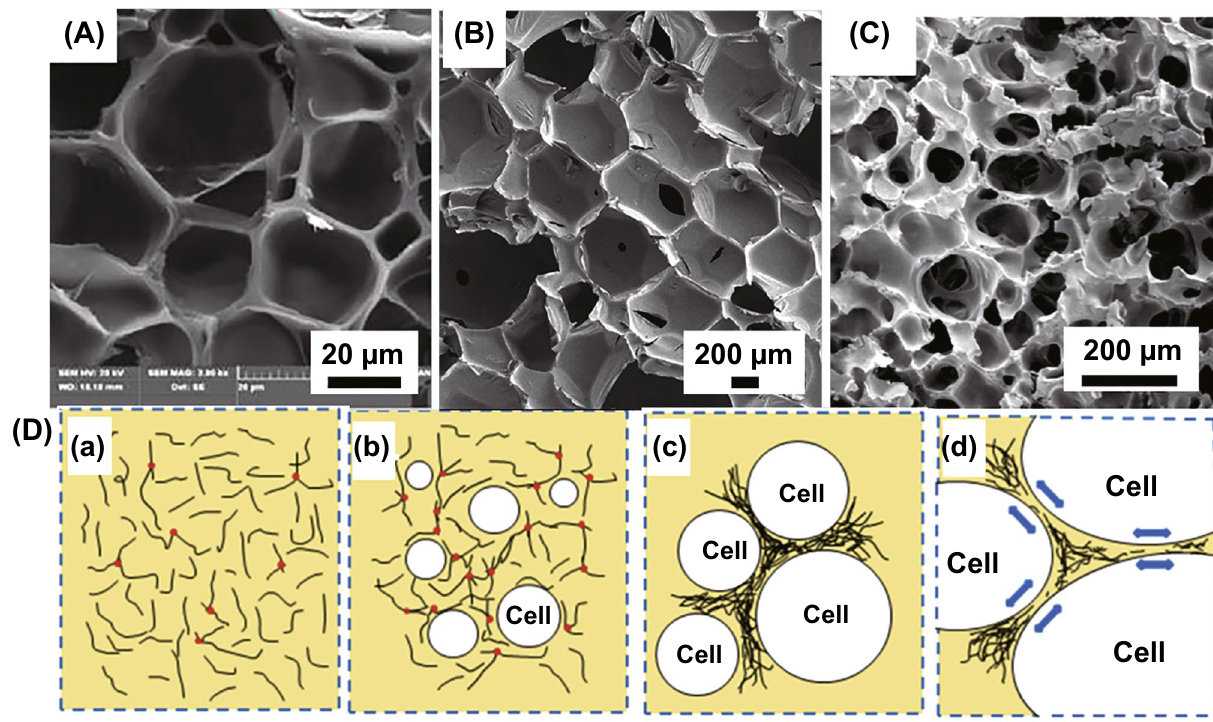
Fig. 3 Cellular structure of polymer foams: A closed-cell foam. Reprinted with permission from Ref. [69]. B Partially open-cell foam and C open-cell foam. Reprinted with permission from Refs. [18, 70]. D Schematic diagram of the microstructural changes foaming process with the growth of cells. The black lines represent the filler, and the arrows show the growth directions of the bubbles during foaming. Reprinted with permission from Ref.